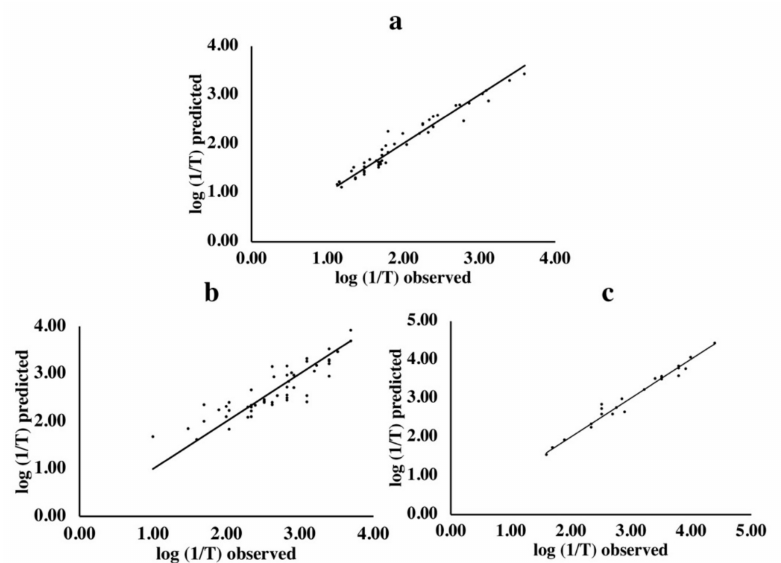
Figure 1. Observed vs. predicted bitter activities of di- ( a ), tri- ( b ) and tetrapeptides ( c ). The x -axis represents the observed sensory values from literature. The y -axis represents the corresponding predicted values derived from the model having the lowest root mean square error cross validation (RMSECV) obtained by 100 bootstrapping soft shrinkage (BOSS)